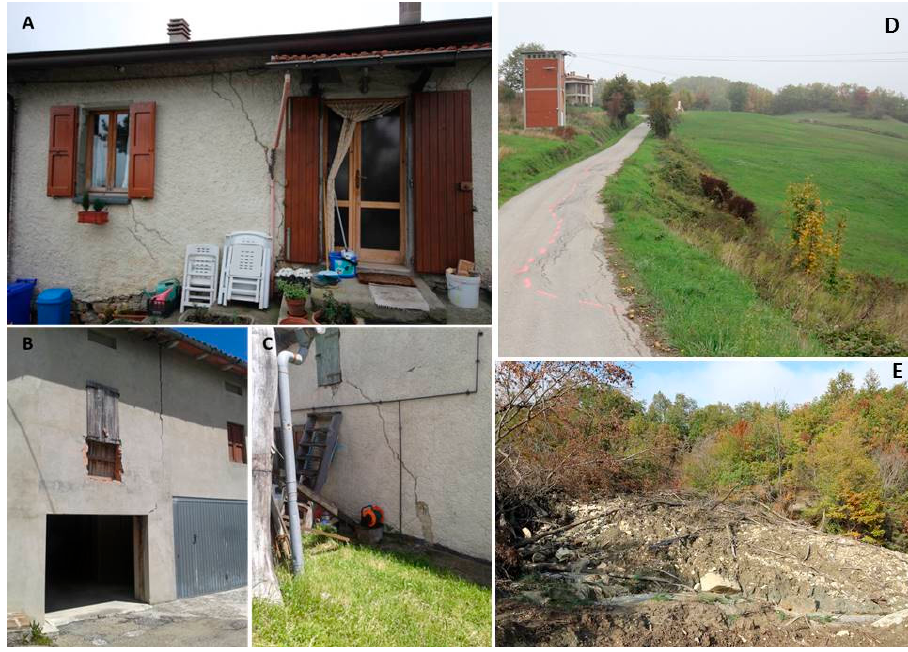
Figure 12. Evidence of movement on Pianestolla buildings ( A – C ) and in correspondence of the sectors δ ( D ) and ε ( E ).